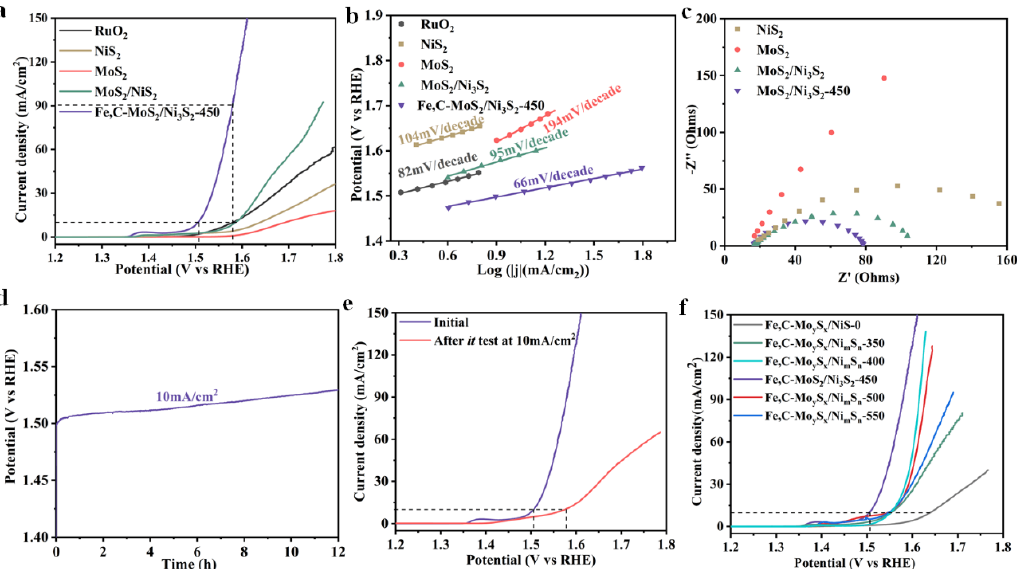
Figure 5. ( a ) Polarization curves and ( b ) the corresponding Tafel plots. ( c ) EIS analysis of the obtained sample for OER. ( d ) Chronopotentiometric curve of HER for the Fe,C-MoS 2 /Ni 3 S 2 -450 ( e ) LSV polarization curves of the Fe,C-MoS 2 /Ni 3 S 2 -450 before and after i-t test (The stability test was carried out by the i-t curve) at 10 mA/cm 2 . ( f ) LSV polarization curves of samples by different annealing temperatures.